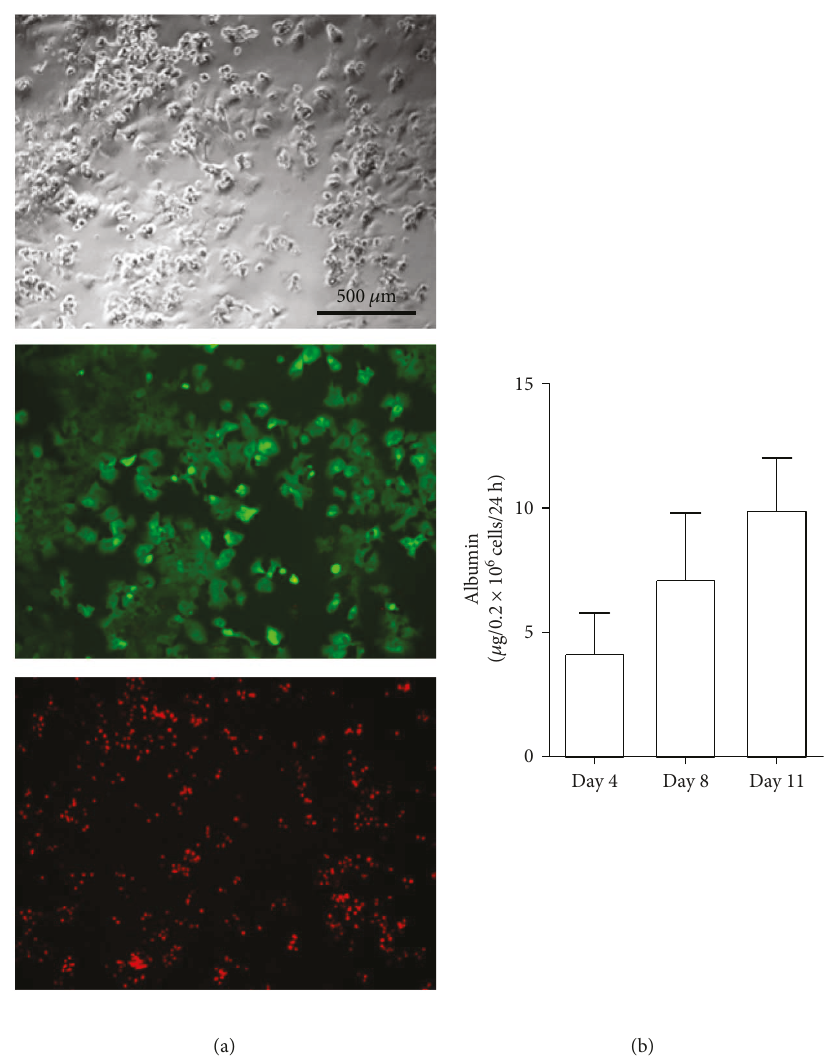
Figure 2: Hepatocyte viability and function after freezing and thawing. (a) The upper panel presents the bright- fi eld image of thawed hepatocytes in culture after 3 days, the middle panel presents viable cells (FDA staining), and the lower panel presents nonviable cells (PI staining). (b) Albumin was measured by ELISA in the supernatant of cultured hepatocytes at days 4, 8, and 11. The experiment is performed in